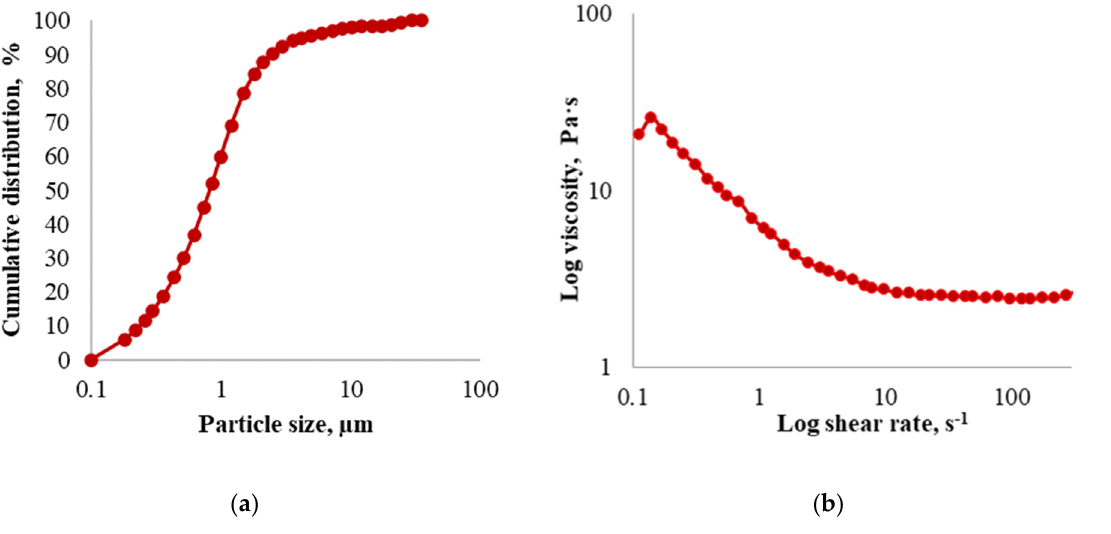
Figure 4. ( a ) Particle size distribution of the dispersant-treated powder; ( b ) Viscosity of the prepared slurry.